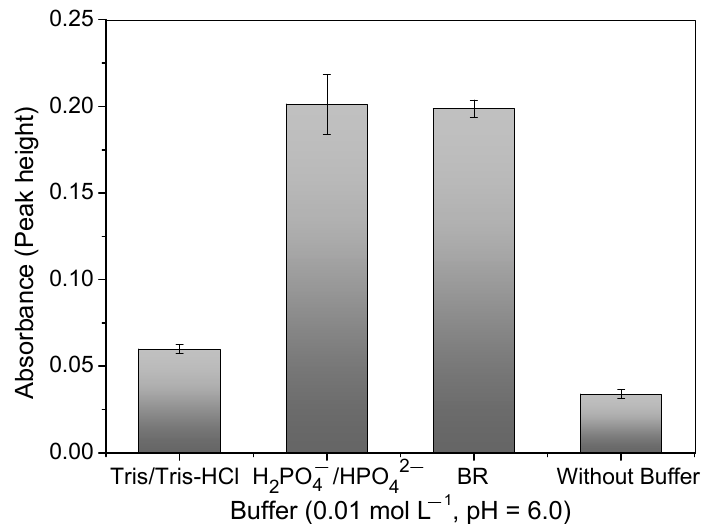
Figure 6. Influence of different buffers (Tris/Tris-HCl, H 2 PO 4 − /H 2 PO 42 − , and BR) and no buffer at pH = 6.0 and 0.01 mol L − 1 on Cu 2+ absorbance signal using polymer in FIA system. Conditions: mass of polymer = 50.0 mg; concentration of Cu 2+ = 100.0 µg L − 1 ; sample volume = 14.0 mL; preconcentration/elution flow rate = 7.0 mL min − 1 ; eluent = 1.50 mol L − 1 HCl.